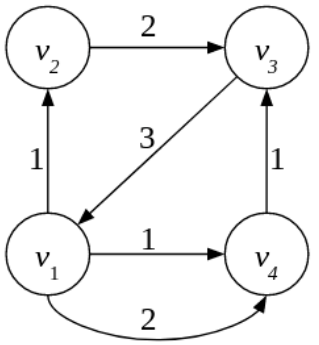
Figure 1. Small obligation